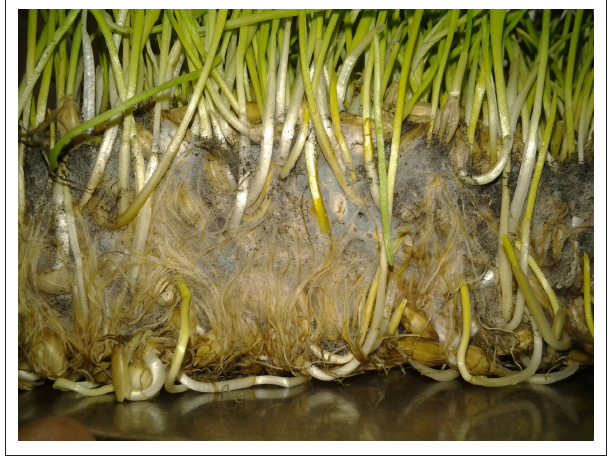
FIGURE 2: Aspergillus clavatus -infected sprouting